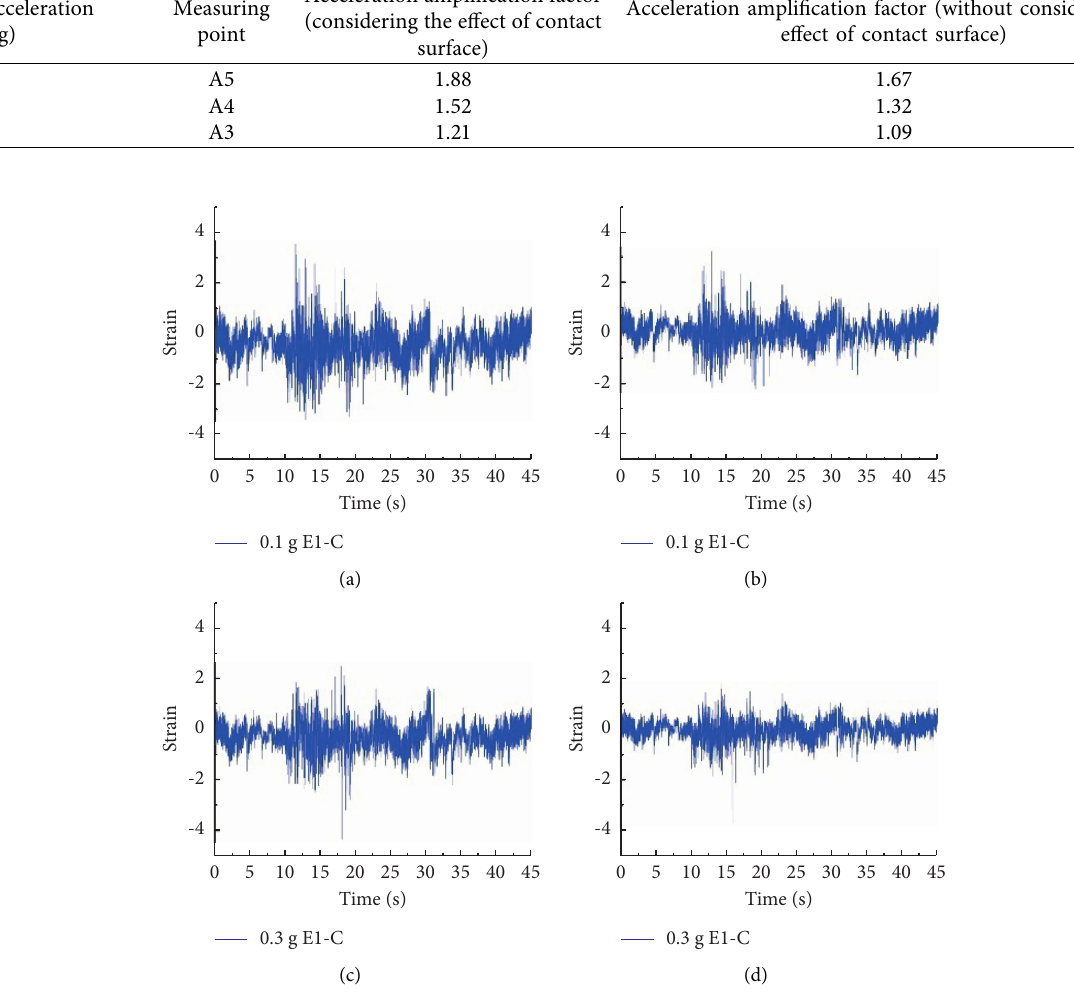
Figure 12: Structure strain time-history curve at 0.5g acceleration.